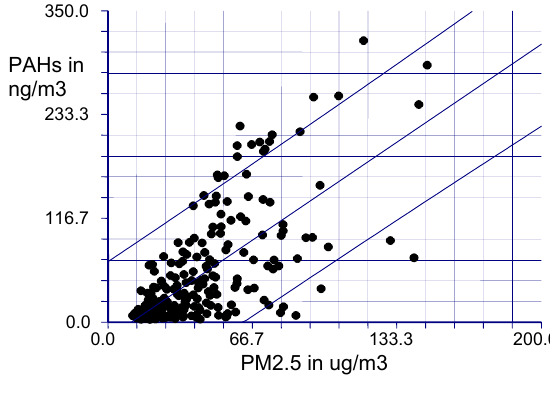
Fig. 1 Scatterplot of exposure to PM25 vs. PAHs. Table 2 Characteristics of study subjects and the respiratory symptoms by level of exposure to PM 2 . 5 and